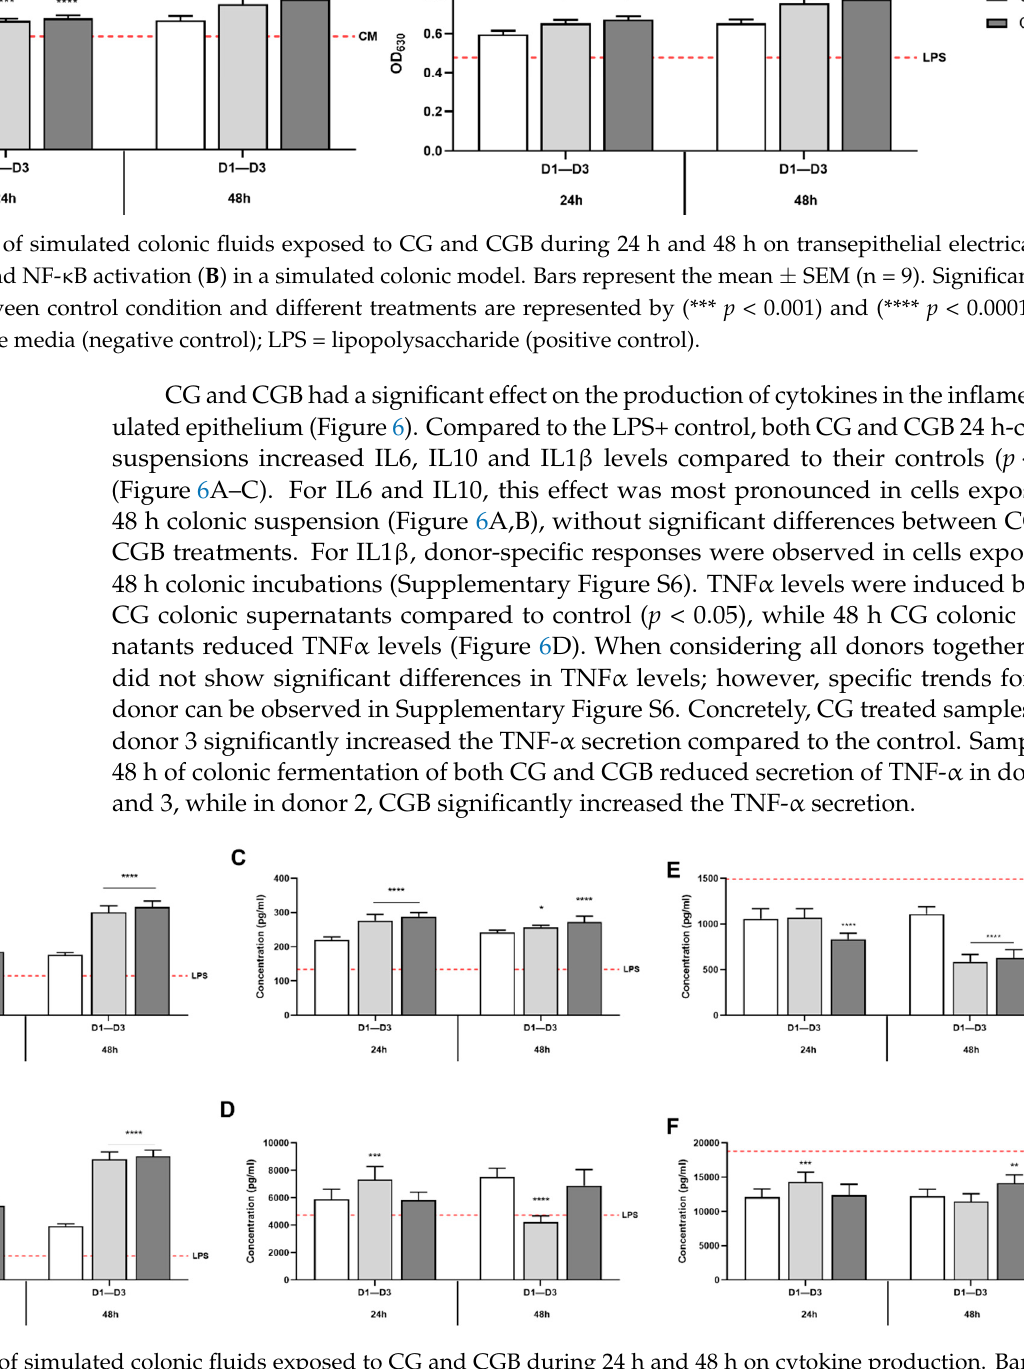
Figure 6. Effect of simulated colonic fluids exposed to CG and CGB during 24 h and 48 h on cytokine production. Bars represent the mean (pg/mL) ± SEM, n = 9 of IL6 ( A ), IL10 ( B ), IL1 β ( C ), TNF α ( D ), CXCL10 ( E ), and MCP1 ( F ). Significant differences between control condition and different treatments are represented by (*). (*), (**), (***), and (****) represent p < 0.05, p < 0.01, p < 0.001, and p < 0.0001, respectively. LPS = lipopolysaccharide (positive control).